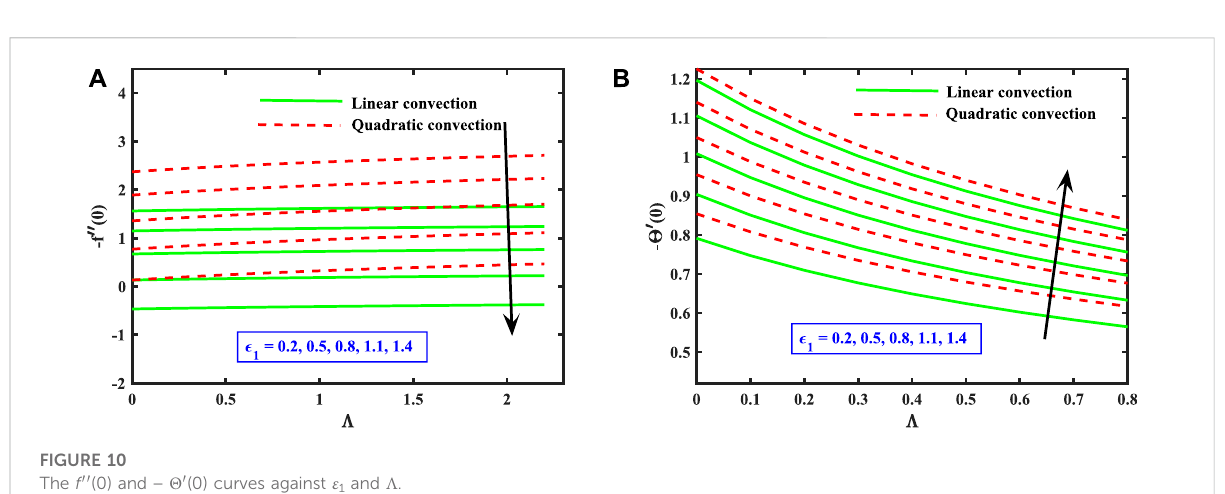
FIGURE 10 The f ′′ (0) and − Θ ′ (0) curves against ε 1 and Λ .